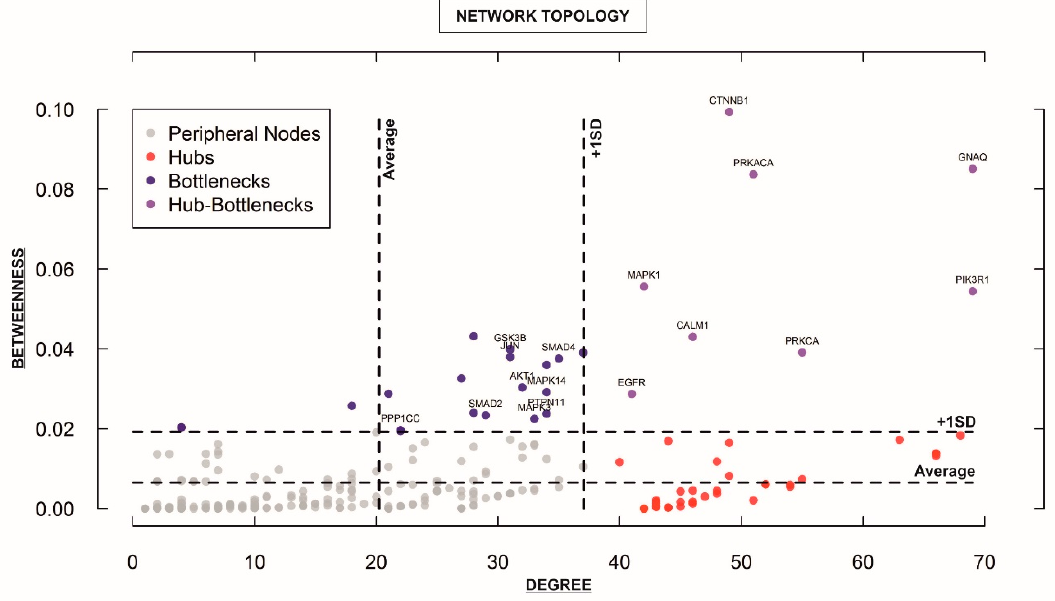
Figure 4. Analysis of the topological properties ( betweenness vs. degree ) of genes/proteins belonging to the “STEMCa” interactome. The figure identifies only central nodes, hub-bottlenecks and nonhub-bottlenecks with values above +1 SD of the mean, which are differentially expressed (corrected p -values < 0.05) in at least one GSE, which is the unique and stable GEO accession number assigned for each series record or group of related samples, it is the ID from GEO for the analyzed datasets from the re-analyzed cohorts (GSE8401, GSE46517, and GSE15605).